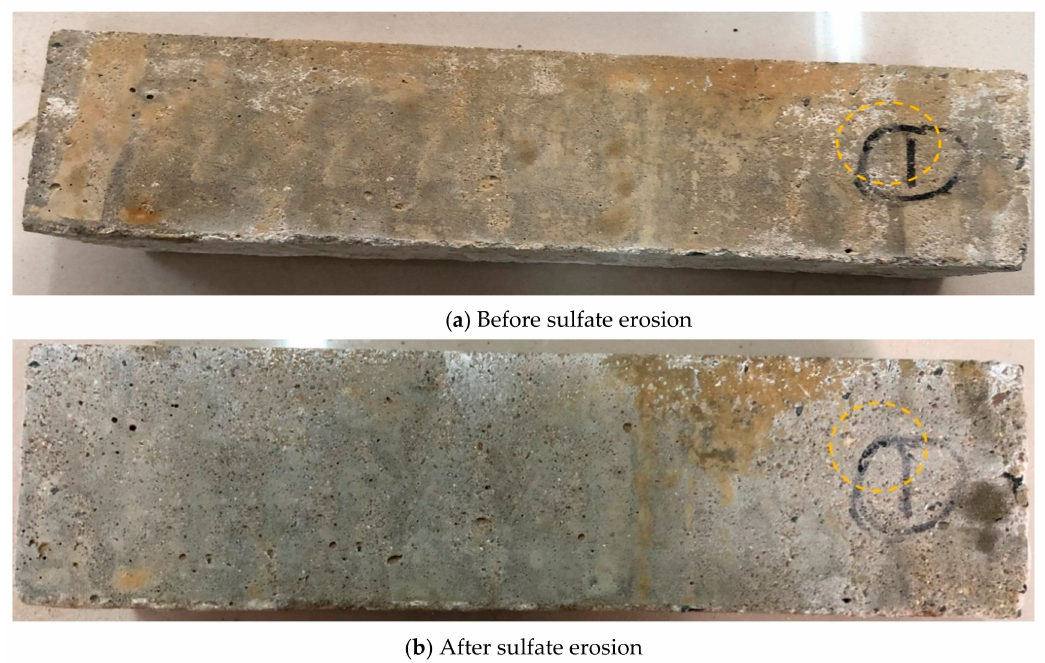
Figure 5. Visual inspection of concrete with dry–wet cycles. ( a ) Before sulfate erosion; ( b ) after sulfate erosion.